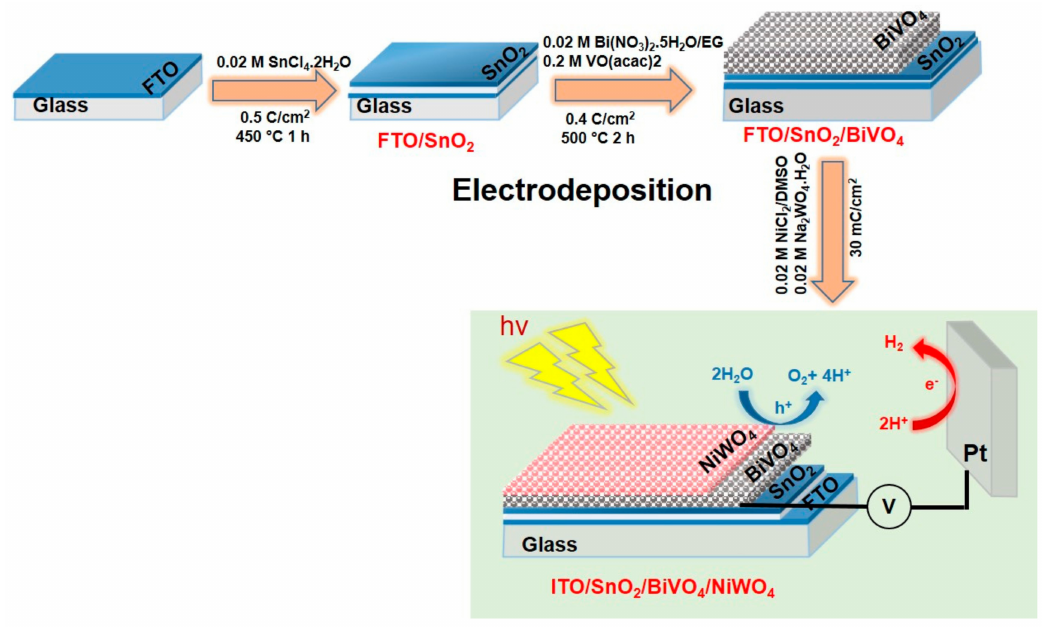
Figure 1. Fabrication of Triple-layer photoanodes. Schematic representation of NiWO 4 / BiVO 4 / SnO 2 triple-layer photoanode film on an fluorine-doped tin oxide (FTO) substrate deposited via a method that involves electrodeposition